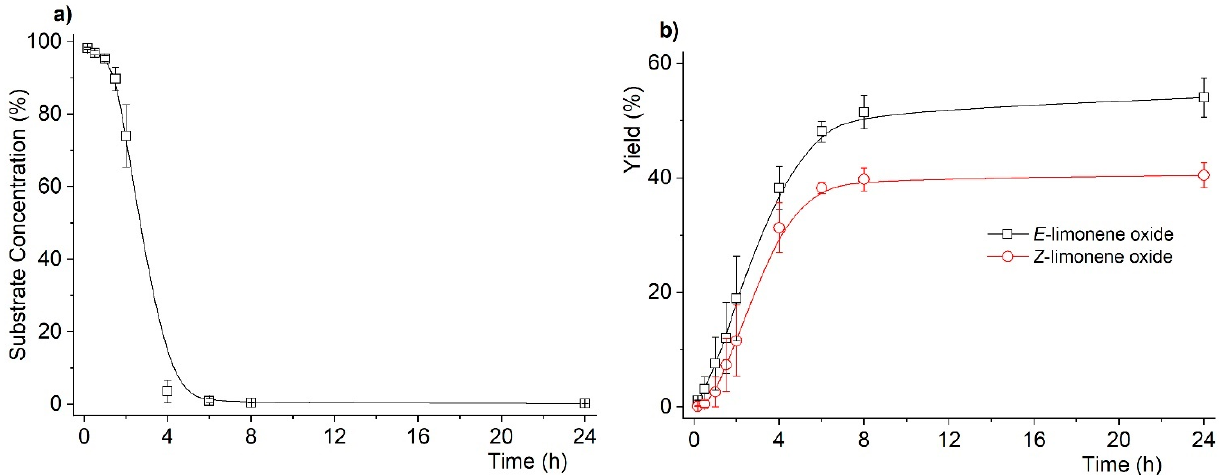
Figure 7. R -(+)-Limonene conversion ( a ) and limonene oxide yield ( b ) for MNP 11 -Si-phos-Mo catalyst at 383 K across three catalytic cycles. The data points represent the average values from the three runs and the error bars account for the observed variations. In ( b ), the limonene oxide yield plot reports the kinetics for the formation of both cis ( Z ) and trans ( E ) diasteriomers of limonene oxide.